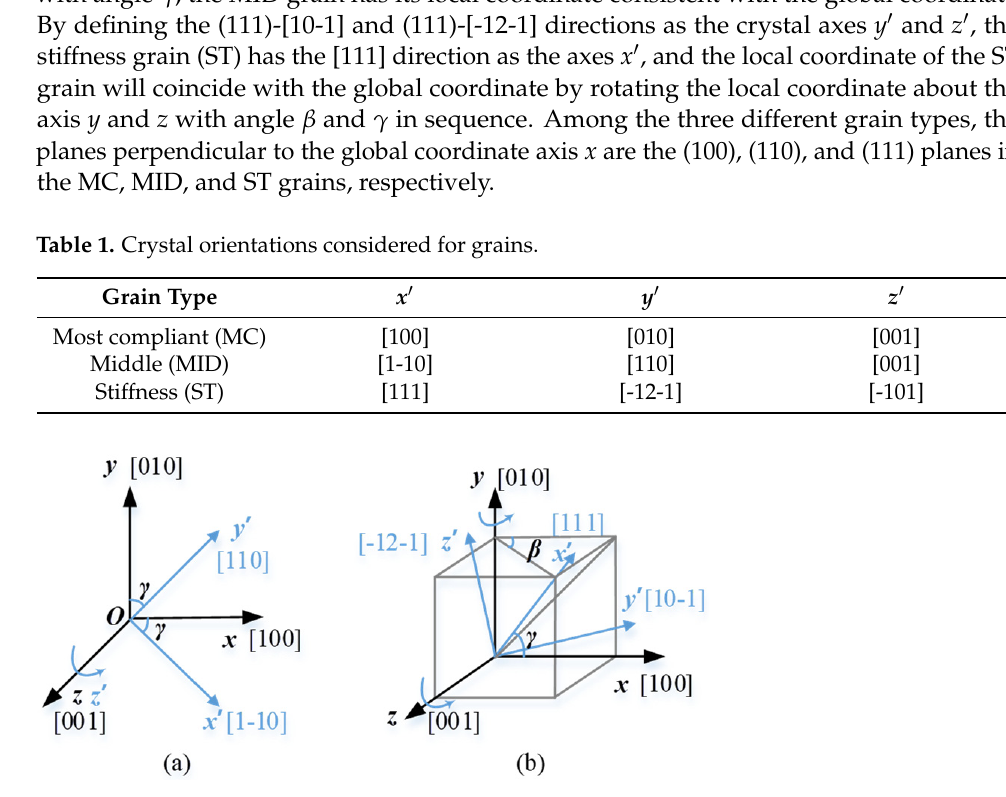
Figure 3. Grain formation process: ( a ) MID grain, and ( b ) ST grain.